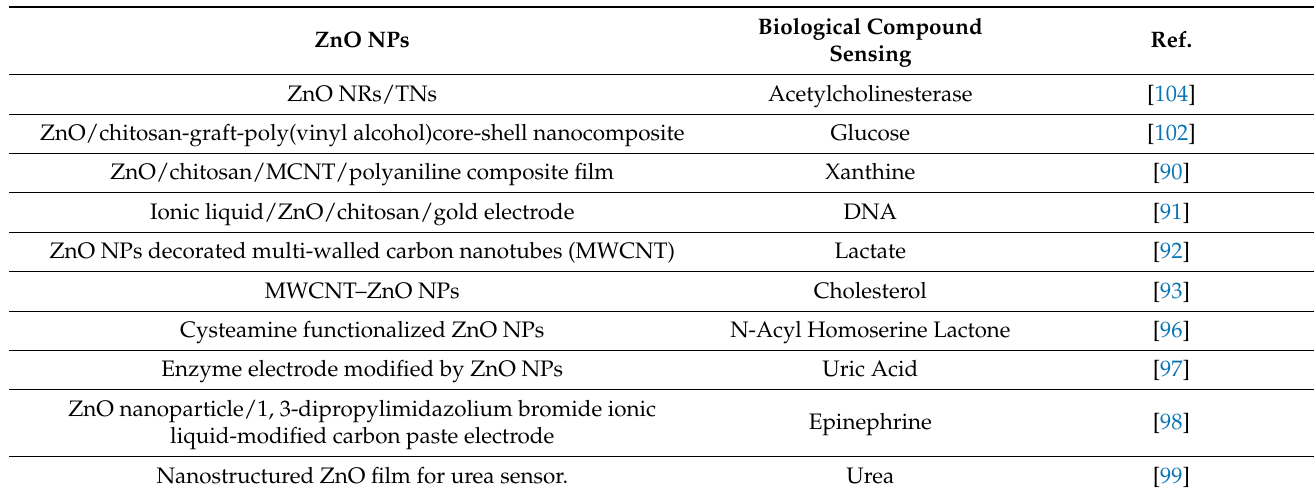
Table 3. Applications of ZnO NPs in